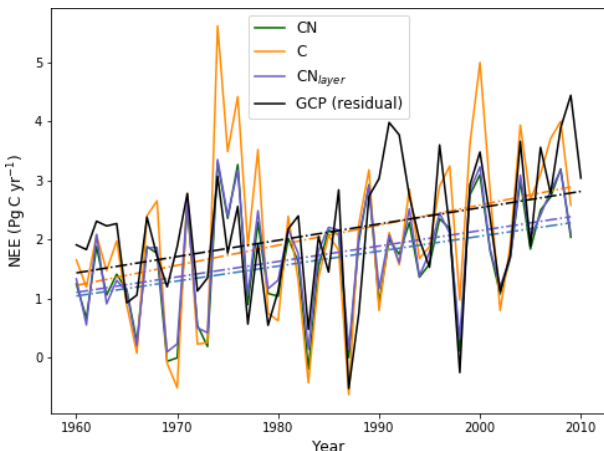
Figure 7. Evaluation of global annual mean NEE from JULES- CN, JULES-C, and JULES-CN layer compared with observations based on estimates from Global Carbon Project (GCP) (Friedling- stein et al., 2020) over the period from 1960 to 2009 inclusive. Pos- itive values represent the land surface as a net sink of carbon. The solid lines are the data and the dashed–dotted lines represent a linear fit of the data against